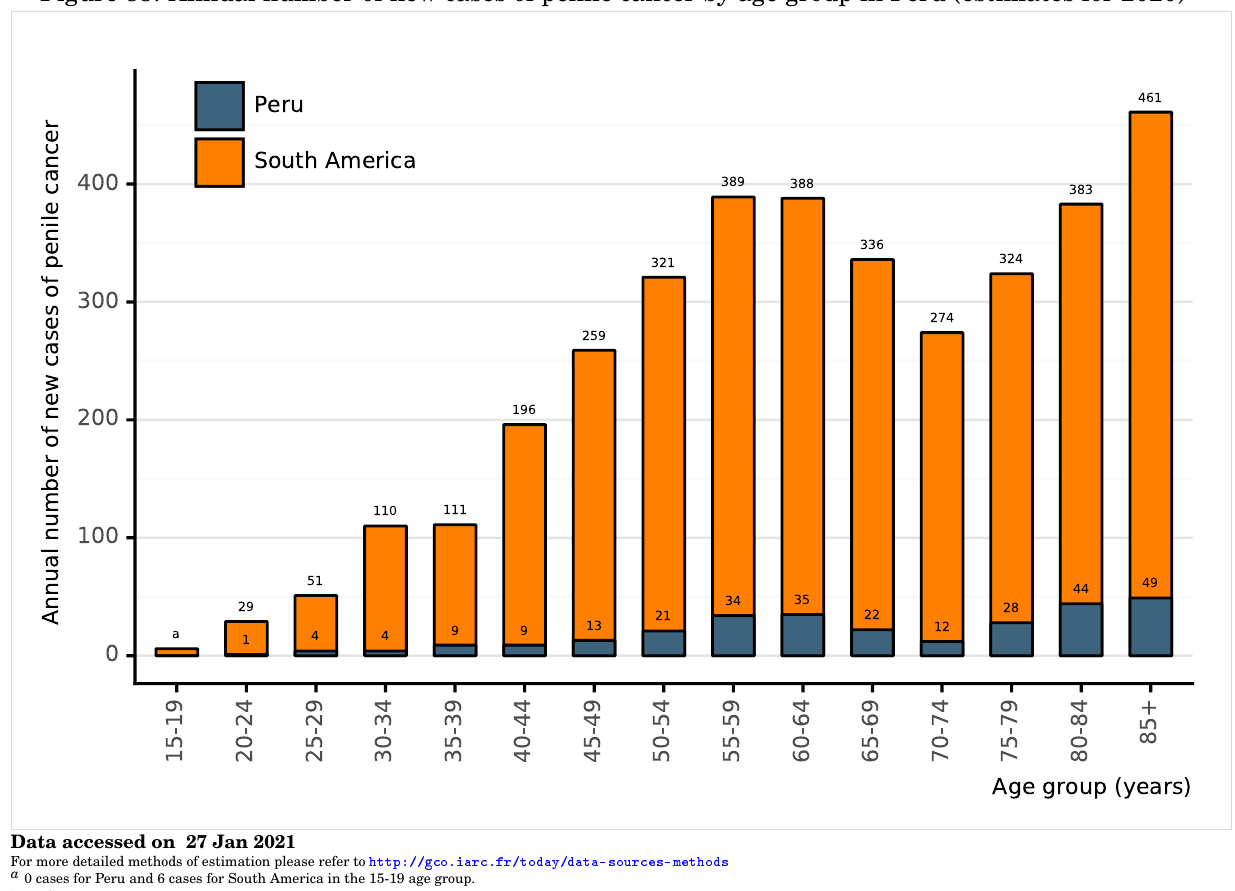
Figure 88: Annual number of new cases of penile cancer by age group in Peru (estimates for